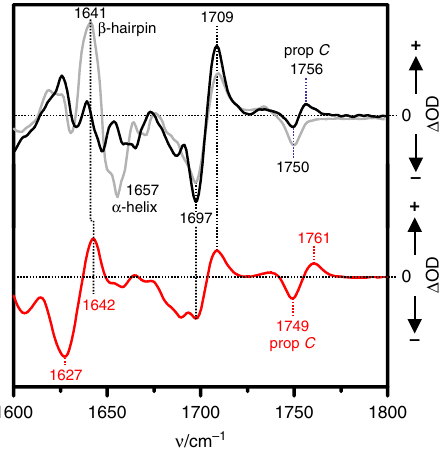
Fig. 8 Photoinduced infra-red (IR) difference spectra of Agp2 variants in solution. Black trace (top): wild-type Agp2-PCM difference spectrum obtained after irradiation at ca. 240 K corresponding to the Meta-F-minus- Pfr difference spectrum (taken from ref. 17 ); red trace (bottom) Agp2- PAiRFP2, difference spectrum obtained after irradiation at 273 K. The grey trace (top) refers to the difference spectrum Pr-minus-Pfr of full-length wild-type Agp2, generated upon irradiation at 273 K (spectrum taken from ref. 17 ). Note that the Pr state could not be enriched for the wild-type Agp2- PCM due to the fast thermal back conversion to the Pfr state 60 . In each spectrum, the negative signals refer to Pfr, whereas the positive signals correspond to the respective